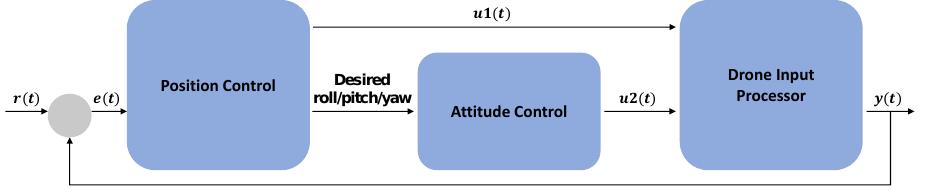
Figure 3. The PID feedback loop for position and attitude control of a quadrotor. Given the desired point r ( t ) and sensed point y ( t ) , the error term e ( t ) is computed and fed to the position controller. Next, the position controller produces a control input u 1 ( t ) and determines the desired roll, pitch, and yaw angles. Then, the attitude controller produces a control input u 2 ( t ) given the desired angles. The control inputs u 1 ( t ) and u 2 ( t ) are fed to the drone input processor to control the